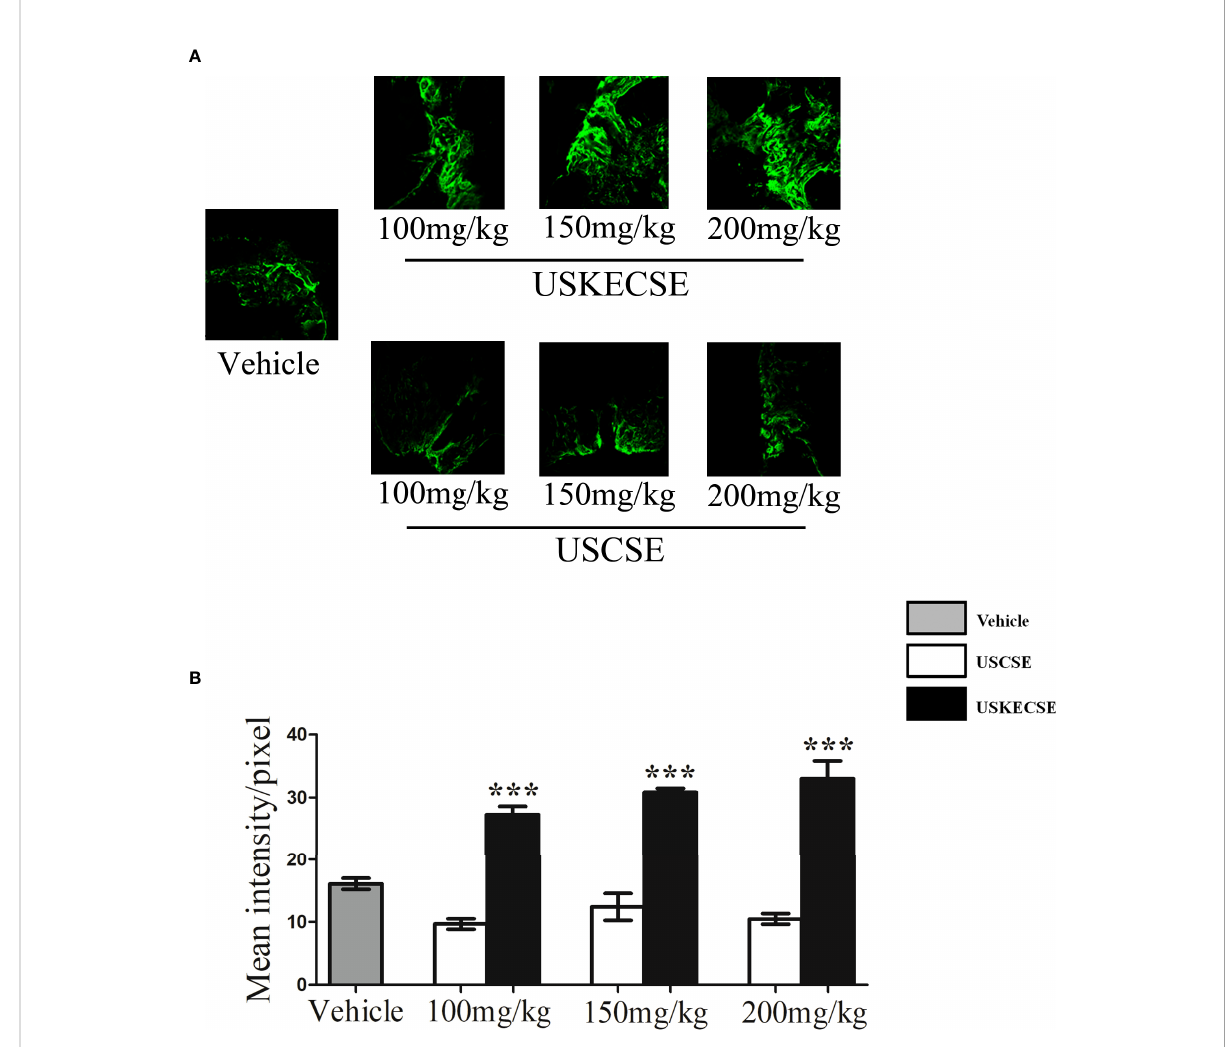
FIGURE 3 USKECSE promoted bone regeneration at the femur osteotomy site. Adult female rats were treated with vehicle, USCSE, or USKECSE at indicated doses 24 hours after femur osteotomy and continued for 12 days. (A) Representative images of calcein deposition at the osteotomy site and (B) quanti fi cation of calcein by confocal microscopy. Values are expressed as mean ± SEM ( n = 6 bones/group); *** p <.001 vs.